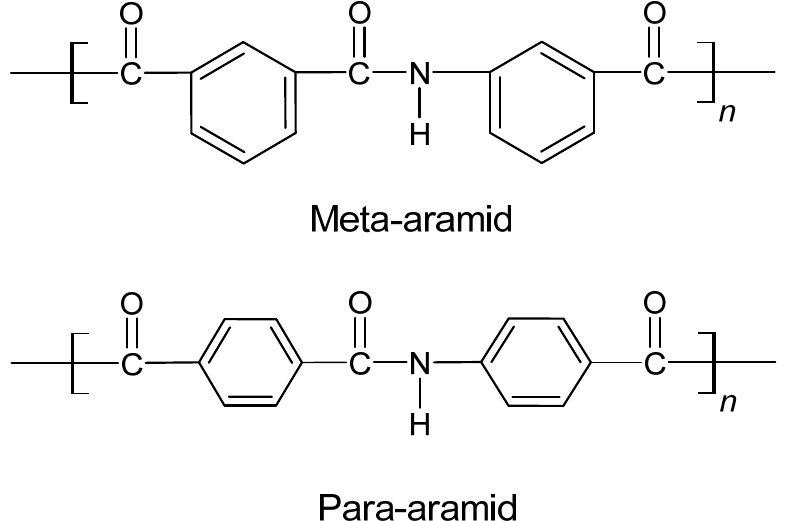
Figure 5. Structures of Meta-Aramid and Para-Aramid fibers.